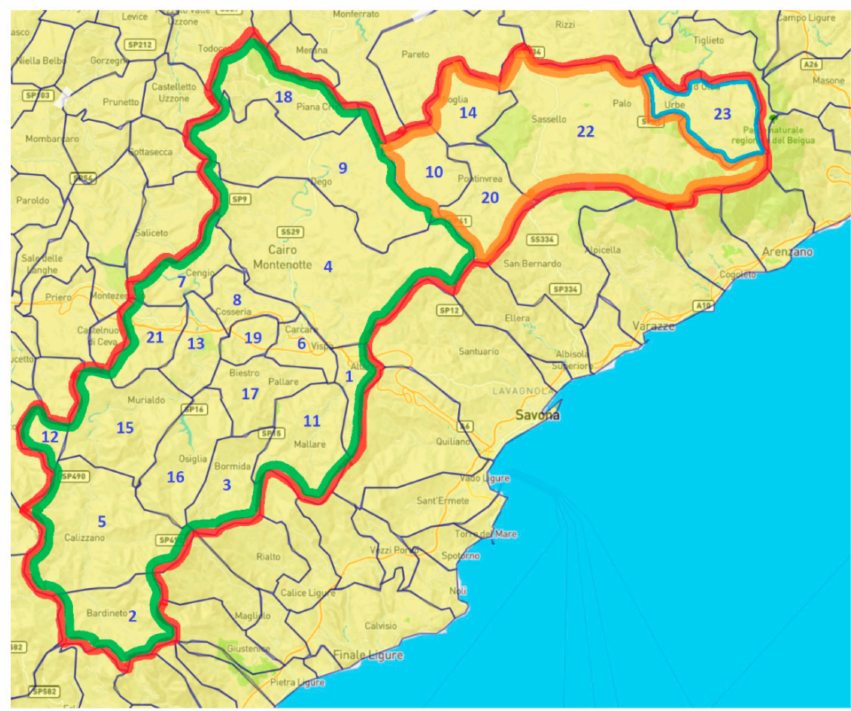
Figure 2. Map of the Bormida